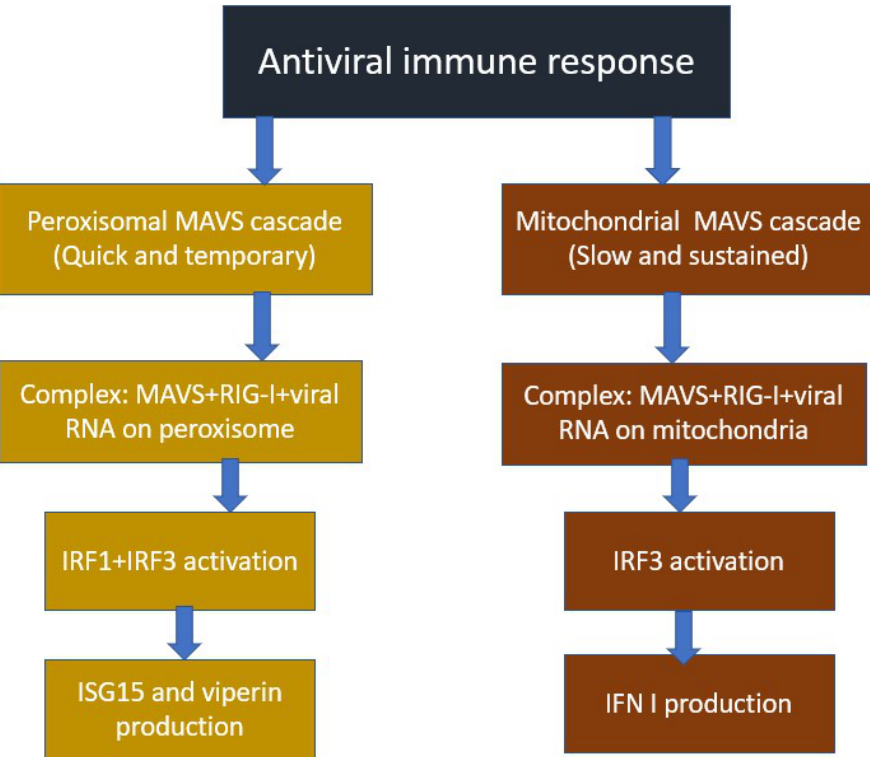
Figure 1. Mitochondrial and peroxisomal MAVS